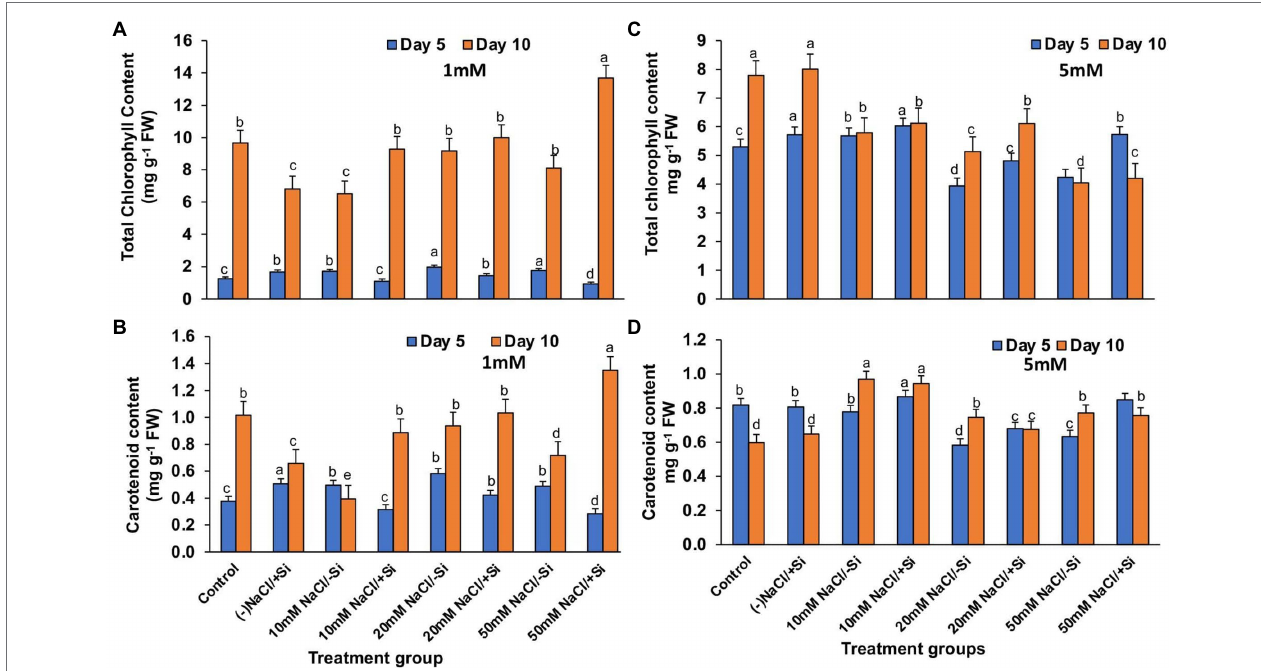
FIGURE 6 | Changes in (A,C) total chlorophyll, (B,D) carotenoid content of mung bean ( Vigna radiata ) under 1 mM (Si 1 ) and 5 mM (Si 2 ) Si supply and salinity stress after eight treatments: (i) control (T1), (ii) − NaCl+Si (1 mM/5 mM) (T2), (iii) 10 mM NaCl/ − Si (T3), (iv) 10 mM NaCl/+Si (1 mM/5 mM) (T4), (v) 20 mM NaCl/ − Si (T5), (vi) 20 mM NaCl/+Si (1 mM/5 mM) (T6), (vii) 50 mM NaCl/ − Si (T7), and (viii) 50 mM NaCl/+Si (1 mM/5 mM) (T8) for a period of 5 and 10 days. Vertical bars indicate Mean ± SE of the means for n = 4. Means denoted by the different letters are significantly different at p ≤ 0.05 according to the Tukey’s studentized range